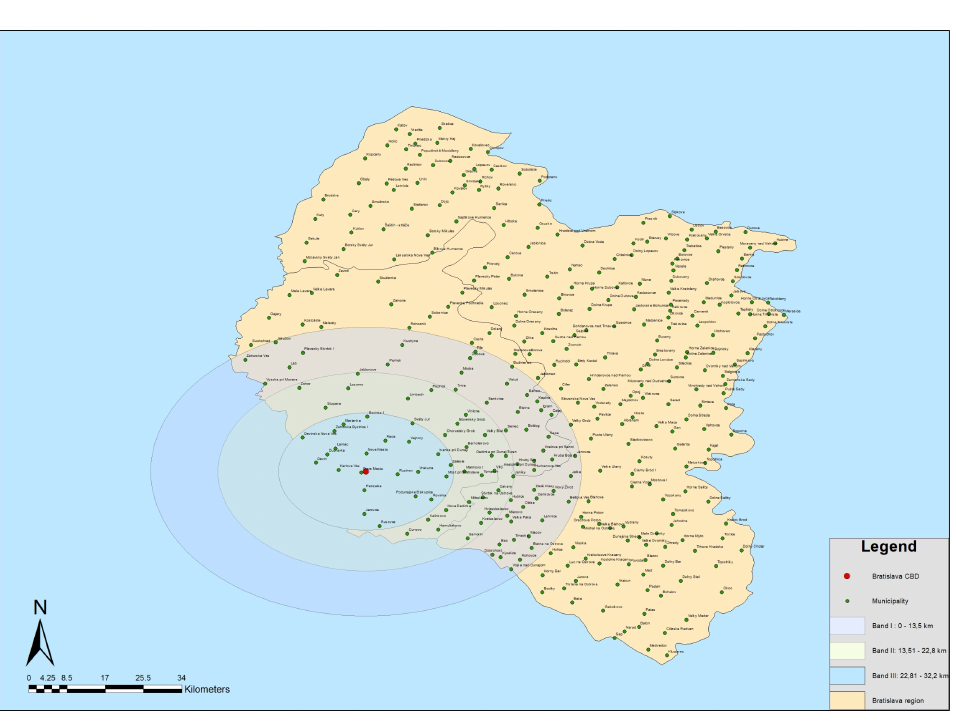
Figure 1: The Bratislava region